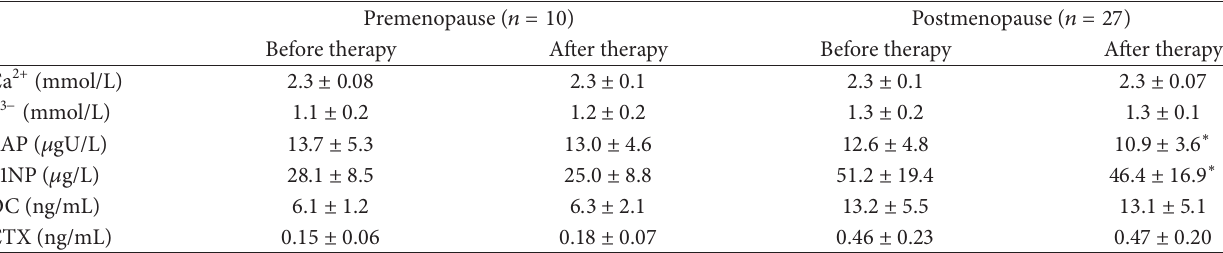
Table 2: Subgroup analyses of bone turnover after pioglitazone treatment in female patients with type 2